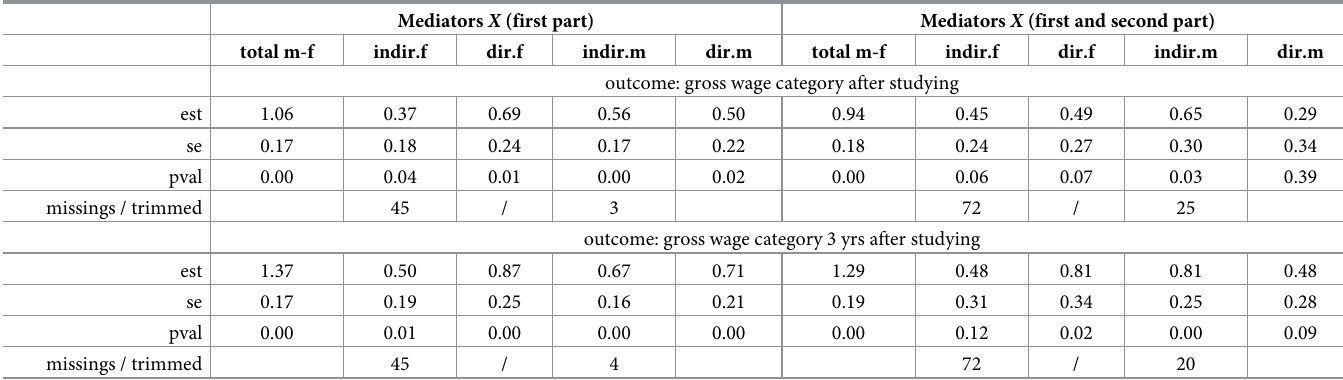
Table 7. Decomposition with trimming equal to